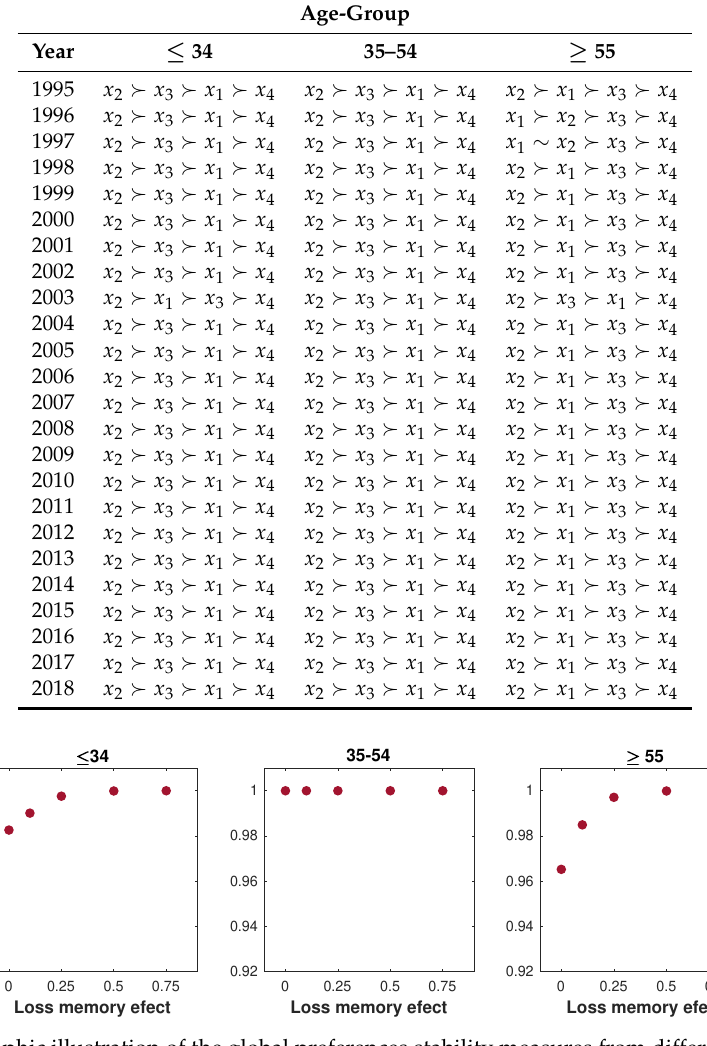
Figure A6. Graphic illustration of the global preferences stability measures from different values of λ and different age ranges for Question